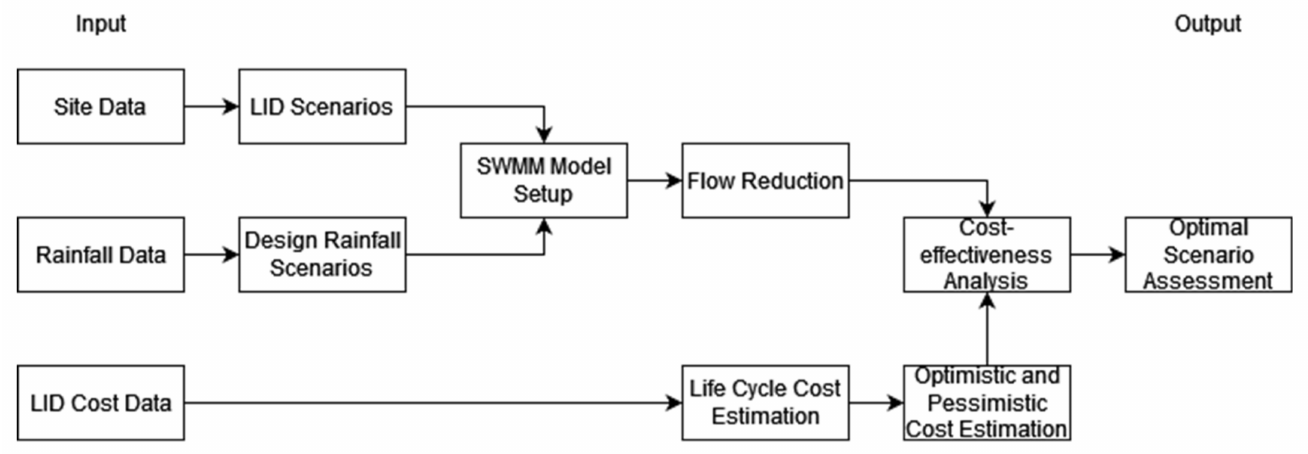
Figure 1. Flowchart of the research